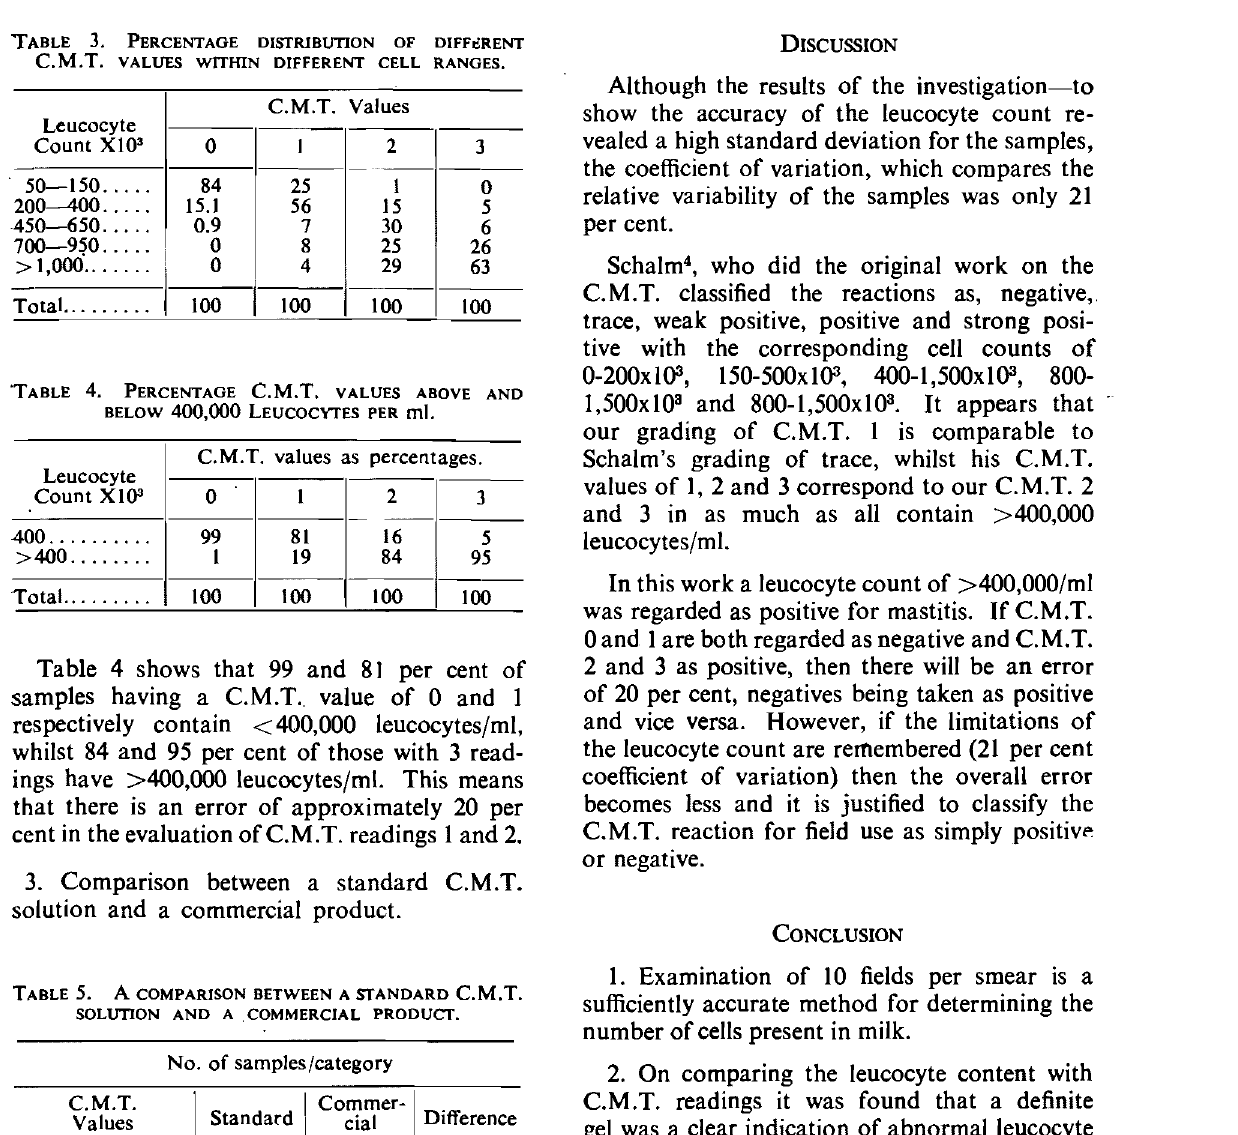
TABLE 3. PERCENTAGE DISTRIBUTION OF DIFFtlRENT C.M.T. VALUES WITHIN DIFFERENT CELL RANGES.